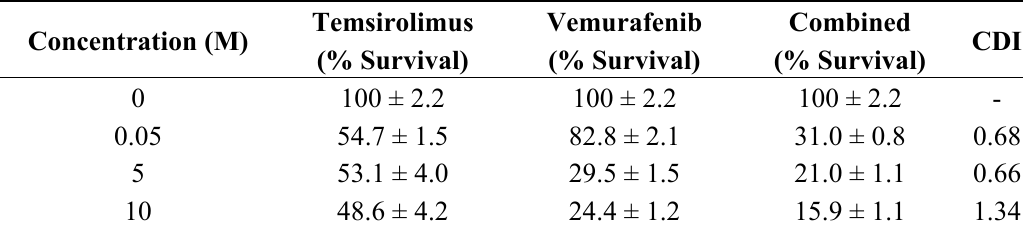
Table 1. Tumor cell survival after treatment of H1_DL2 melanoma brain metastasis cells. CDI, coefficient of drug interaction.